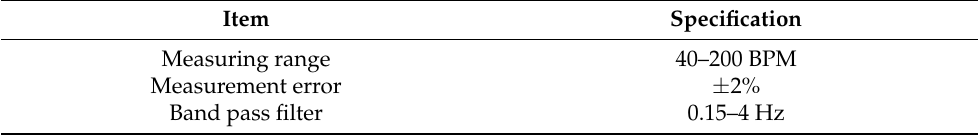
Figure 3. Image of electrode locations for EEG test. Table 5. Specifications of the EEG measurement device. Item